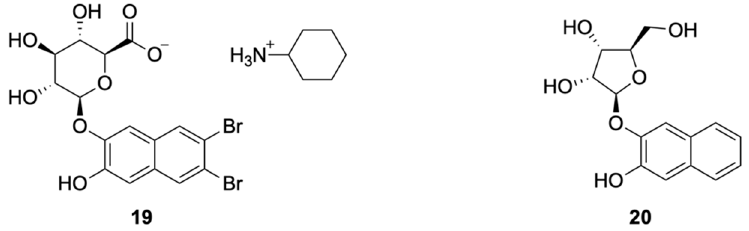
Figure 3. Structures of the β - D -glucuronide derivative 19 and the β - D -riboside derivative 20 [ 43].